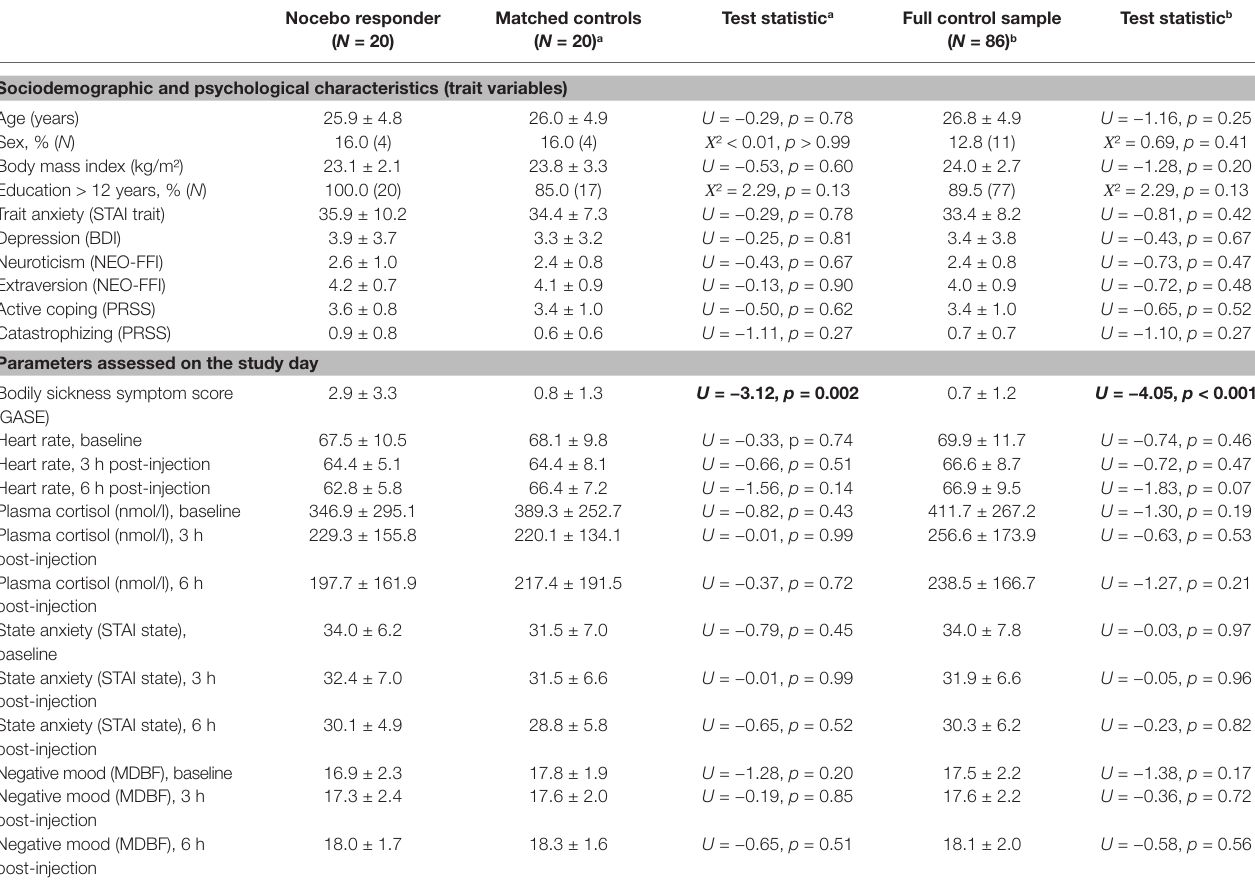
TABLE 1 | Characteristics of nocebo responders and